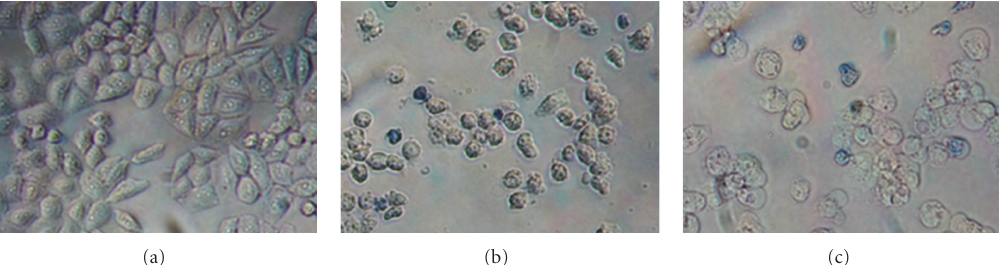
Figure 2: Trypan blue staining of HeLa cells grown in the absence (a) and presence of n-frutalin (b) and r-frutalin (c) (both at 100 μ g/mL) for 48 h (original magnification of × 200).